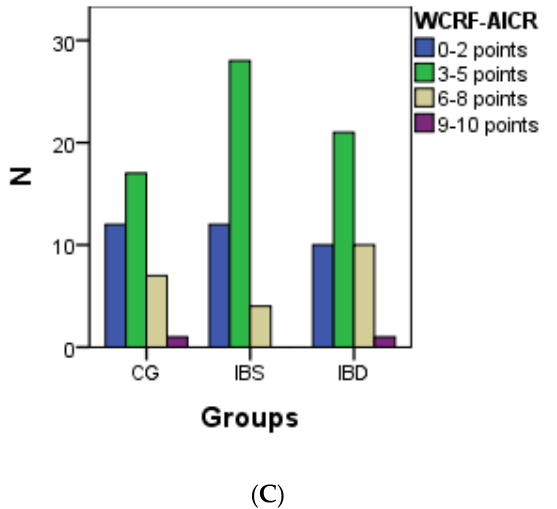
Figure 5. Graphic presentation of the quality of life questionnaires, respectively EORTC QLQ–CR29 ( A ), VAS ( B ), and WCRF/AICR ( C ).